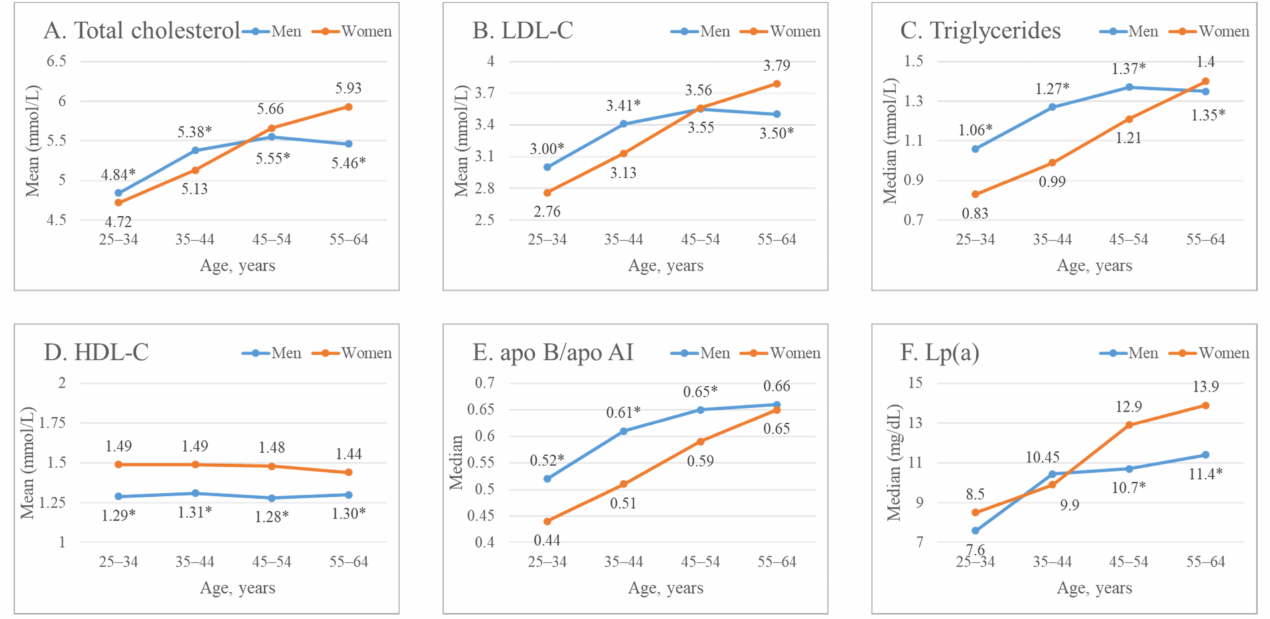
Figure 2. Sex- and age-specific levels of: ( A ) total cholesterol; ( B ) LDL-C; ( C ) Triglycerides; ( D ) HDL- C; ( E ) apoB/ apo AI; ( F ) Lp(a). (*) indicates the significant difference between men and women in the corresponding age